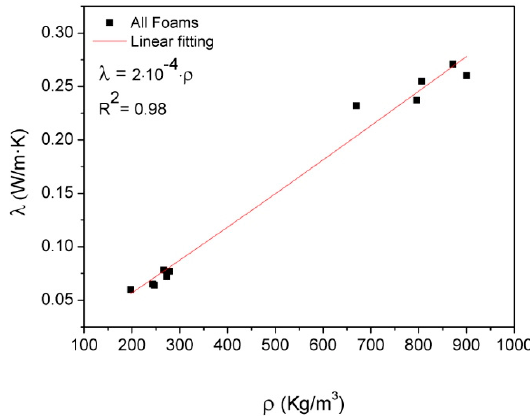
Figure 6. Thermal conductivity as a function of density.